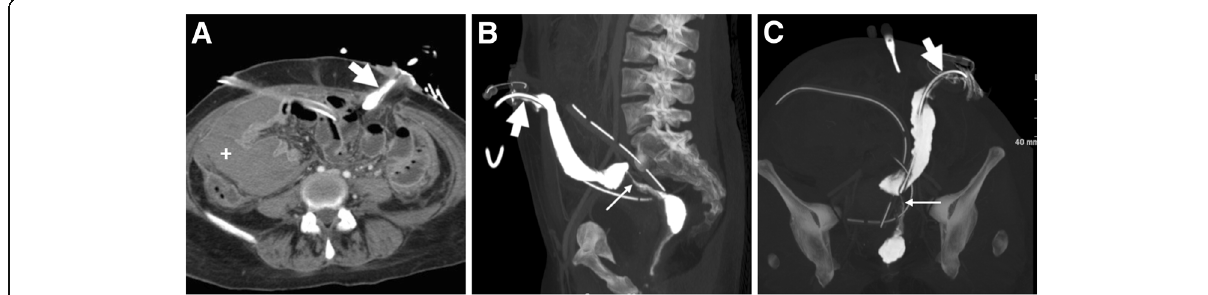
Fig. 7 Combined CT plus WSC-SE in a patient with iatrogenic rectal perforation during stricture dilatation. Axial CT image ( a ) showing large hyperattenuating collection in the right abdomen (+) and diluted iodinated contrast medium injected in the cannulated efferent limb of the loop colostomy (thick arrows). Maximum-intensity projection reconstructions ( b , c ) depict the contrast medium-filled diverted rectosigmoid colon with stricture (thin arrows), without extraluminal leakage. Note drainage tubes in place